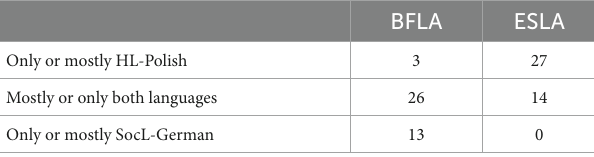
TABLE 9 Children’s language choice with siblings and to self. TABLE 10 Family language choice outside the home across five settings.